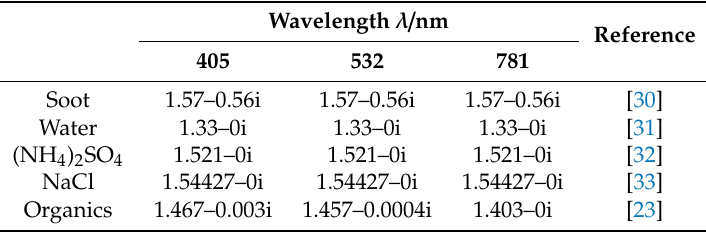
Table 1. Refractive index of core and coating material used for model